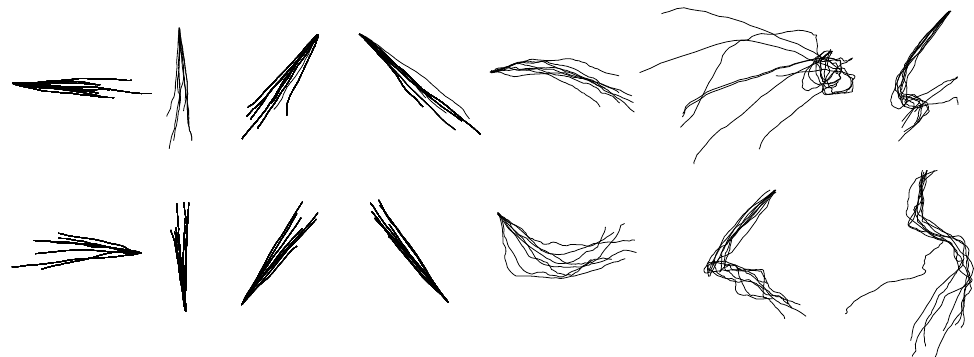
Figure 9. The randomly selected reconstructed drawing traces of within-group reconstruction by the KF.